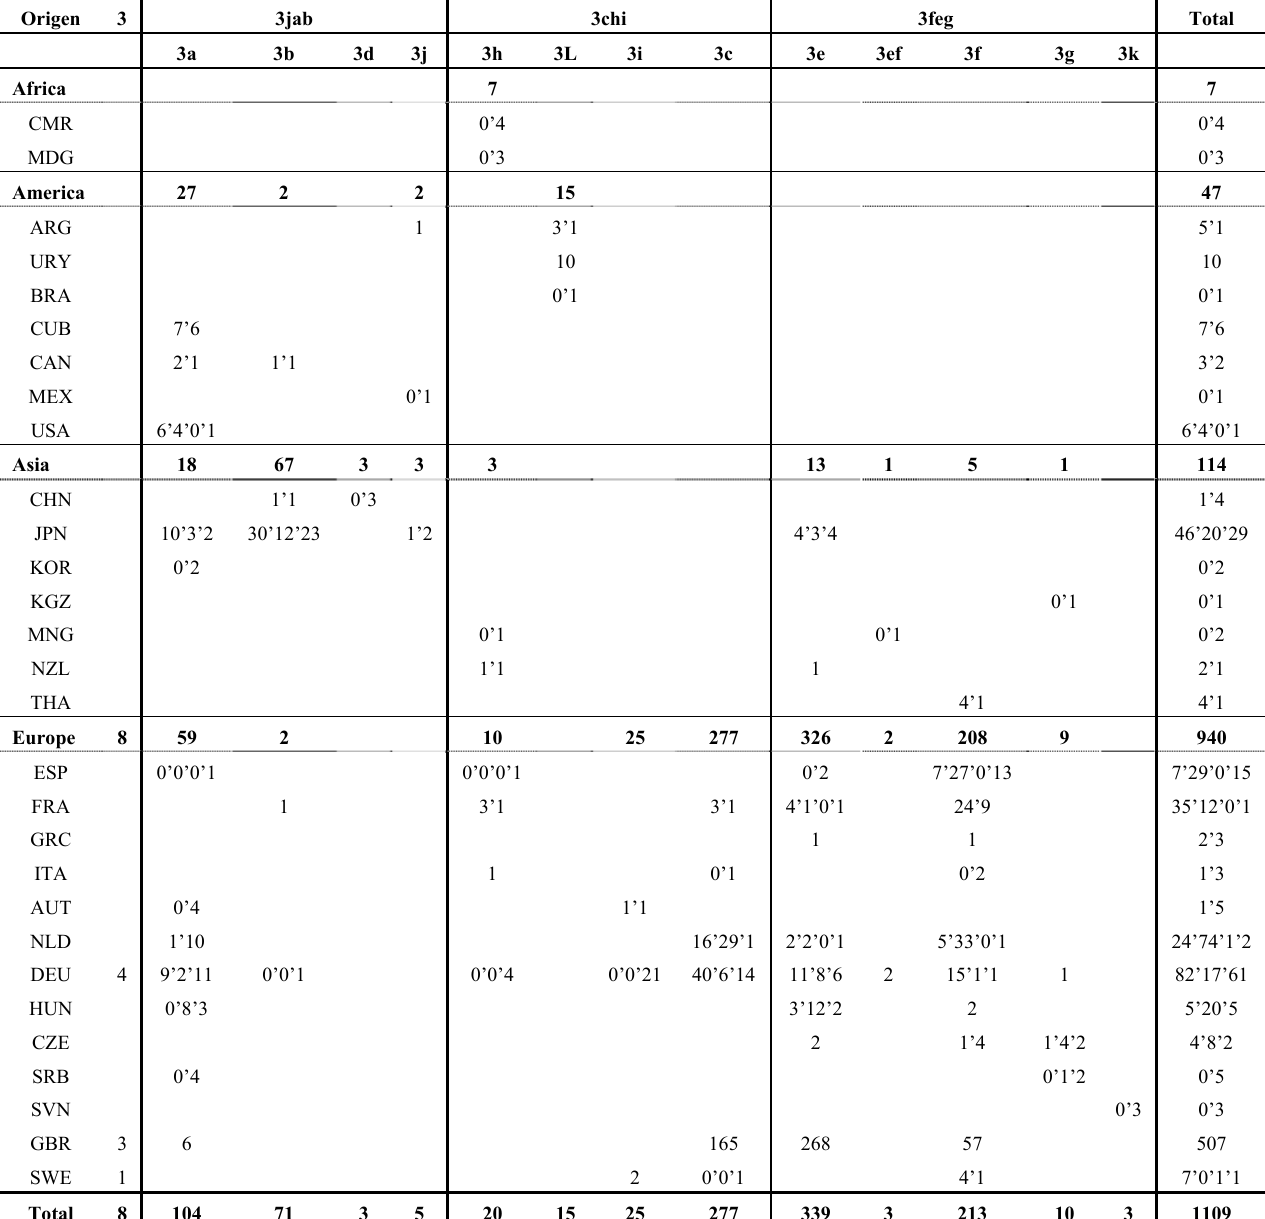
Table 2. Subtype distribution of the 1109 isolates of genotype 3, represented by the 1283 sequences analyzed. Summarized by continent, country, and source—shown in order: human‘pig‘wild animal‘other. For example 1’2’3’4 means: 1 human isolate; 2 isolates from pig; 3 isolates from wild animals; and 4 from others sources (environment samples, water, etc. ). As some isolates have undetermined subtypes and are not shown, not all rows or columns sum the real total. Due to various types of biases in the selection of the biological samples by the original authors and in our selection of sequences, the only approximate analysis possible was the comparison of the proportion of subtypes by host in different countries or regions. An alternative, graphical view is available at Supplementary Figure S13, which can also be explored